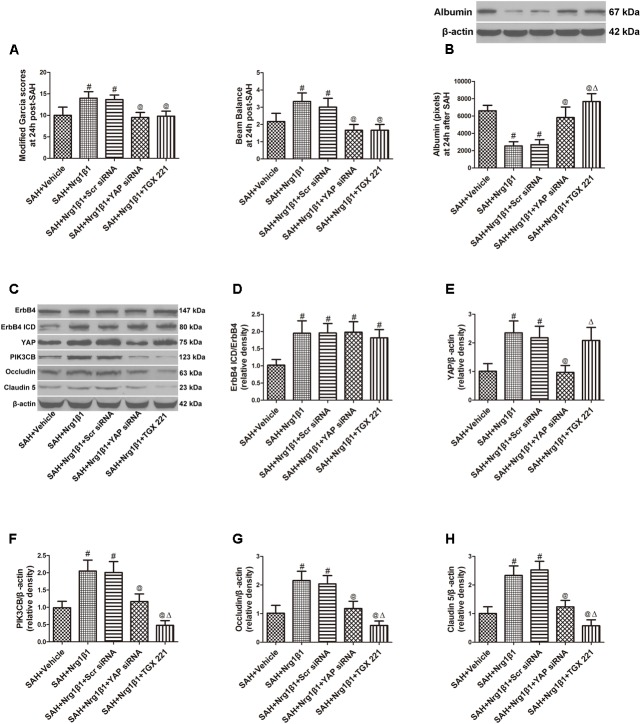
Effects of YAP siRNA pre-treatment on blood-brain barrier integrity at 24 h after SAH. YAP siRNA aggravated neurological deficits (A) and increased albumin extravasation (B). Representative western blot bands of ErbB4, YAP, PIK3CB, Occludin and Claudin 5 (C). YAP knockdown did not affect the ratio of ErbB4 ICD/ErbB4 (D), and reduced the expression of YAP (E), PIK3CB (F), Occludin (G), and Claudin-5 (H). PIK3CB inhibition by TGX 221 had no effect on the expression of ErbB4 ICD/ErbB4 (D) and YAP (E), and significantly reduced the expression of PIK3CB (F), Occludin (G) and Claudin-5 (H). n = 6, #p < 0.05 versus SAH + Vehicle; @p < 0.05 versus SAH + Nrg1β1; p < 0.05 versus SAH + Nrg1β1 + YAP siRNA.